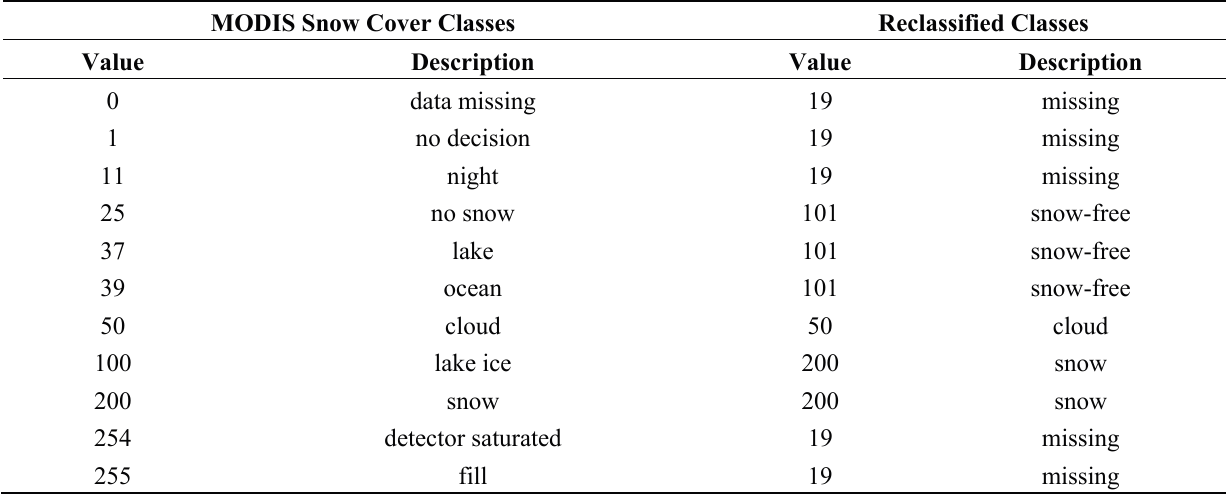
Table 1. Reclassification of MODIS snow cover